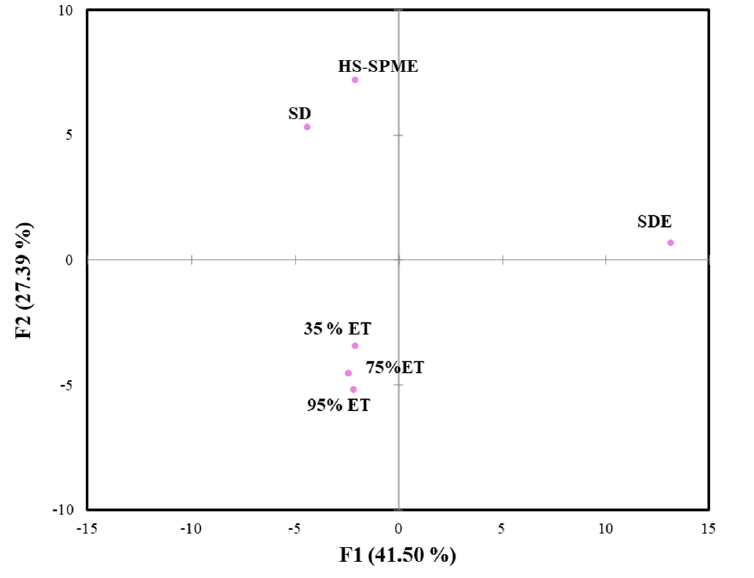
Figure 1. Principal component analysis diagram (PCA) of vanilla pods with different extraction methods. ● : Samples (ET: ethanolic extract) .